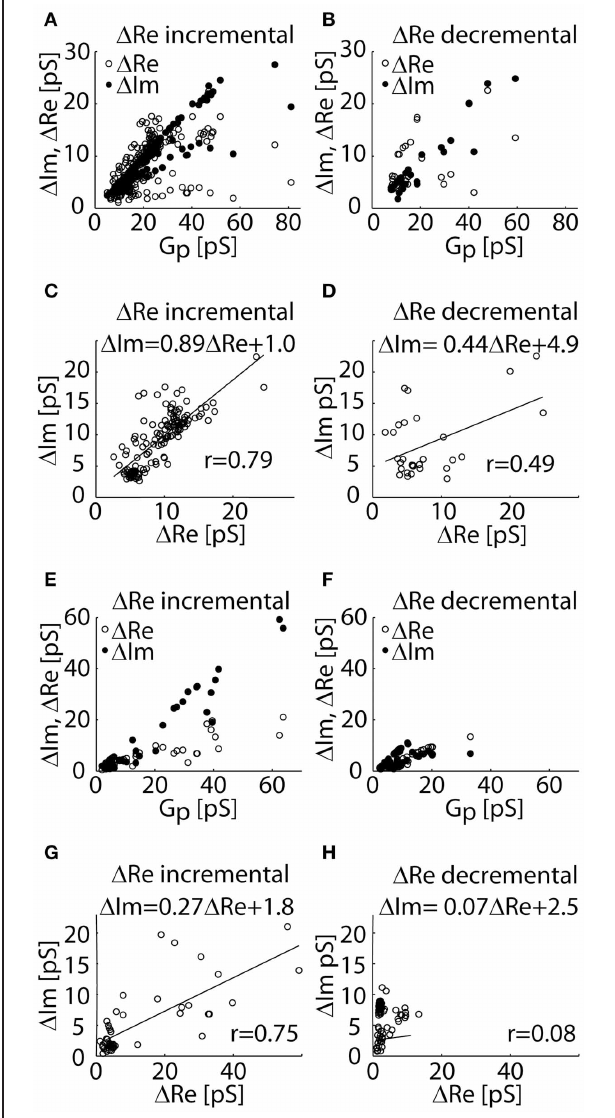
( (cid:2) Im ) parts of admittance signals can be employed for the cal- culation of C v and G p (Lindau, 1991; Lollike and Lindau, 1999). In Figure 4 , (cid:2) Re and (cid:2) Im are plotted as a function of G p calculated for intermediate ( C v = 1 . 2 fF), large ( C v = 4 fF), and small ( C v = 0 . 5 fF) vesicles, representing events of case I, II, and III, respectively. The fact that in case I there is no projection on the Re trace can be reproduced by a change from a fully closed fusion-pore state ( G p = 0 pS) to a fully open fusion-pore state